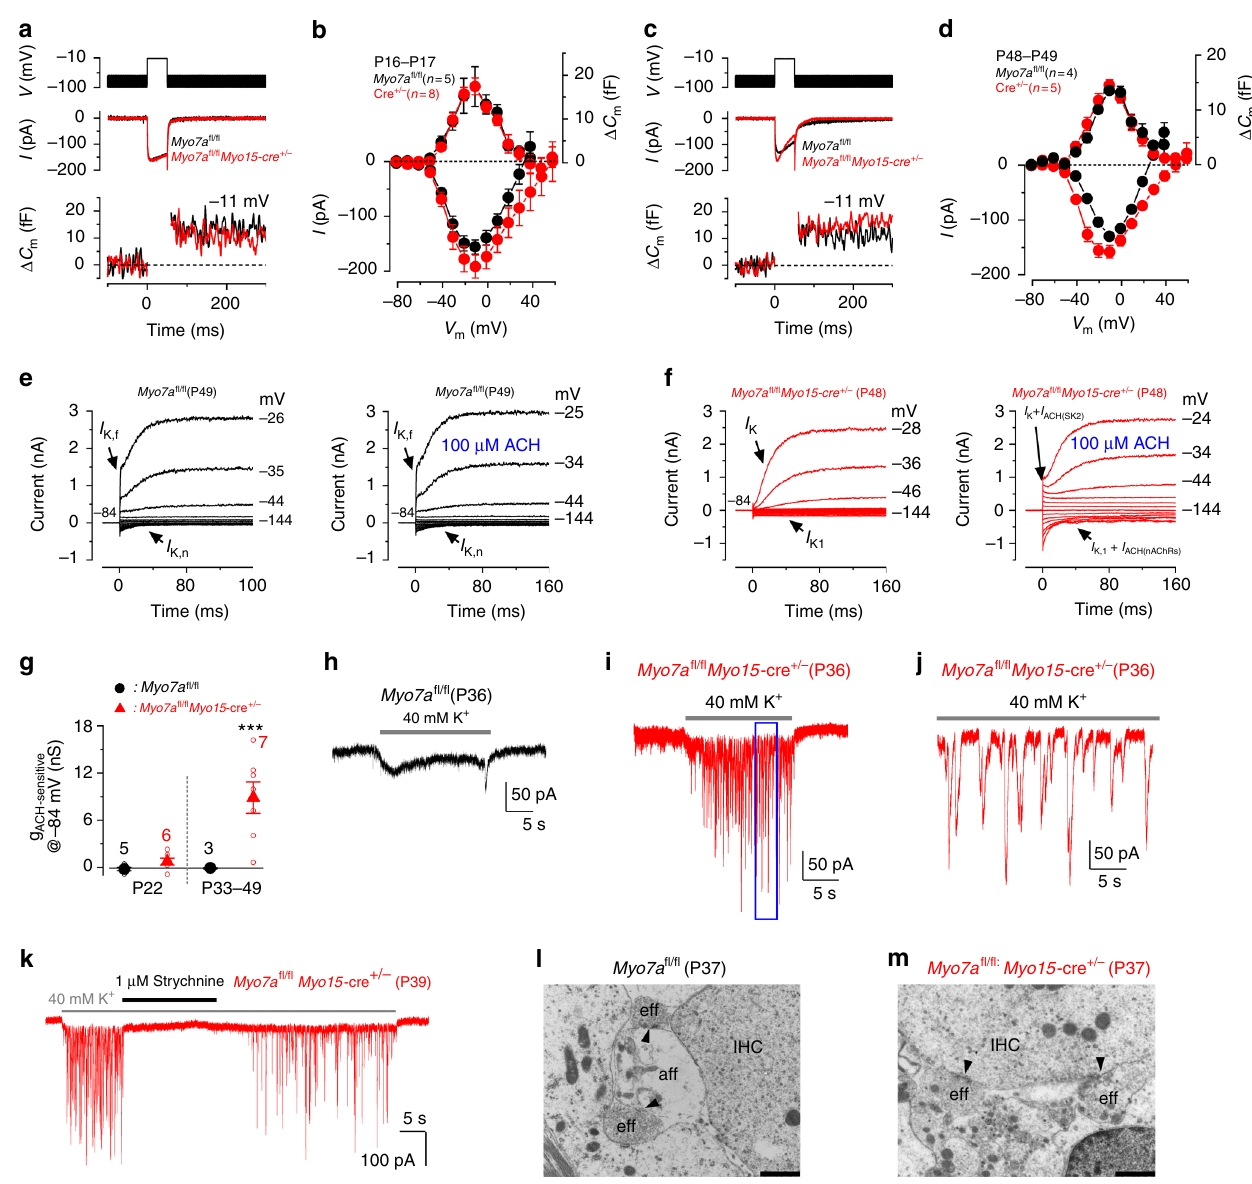
Fig. 7 IHC exocytosis is unaffected in adult Myo7a fl / fl Myo15 -cre + /- mice but efferent input is altered. a − d Calcium current ( I Ca ) and corresponding changes in membrane capacitance ( Δ C m ) recorded from IHCs of P16-P17 ( a , b ) and P48-P49 ( c , d ) control Myo7a fl / fl (black) and knockout Myo7a fl / fl Myo15 -cre + /- mice (red). Recordings were obtained in response to 50 ms voltage steps (10 mV increments) from − 81 mV and using 1.3 mM extracellular Ca 2 + and at body temperature. For clarity, only maximal responses at − 11 mV are shown. Panels b and d shows average peak I Ca (bottom) and Δ C m (top) curve from control Myo7a fl / fl and Myo7a fl / fl Myo15 -cre + /- IHCs. e , f Membrane currents recorded from adult IHCs of control Myo7a fl / fl ( e ) and Myo7a fl / fl Myo15 -cre + /- ( f ) mice before (left panels) and during superfusion of ACh (right panels). ACh elicited an instantaneous current only in the Myo7a fl / fl Myo15 -cre + /- IHC. g Steady-state slope conductance of the ACh-sensitive current (g ACh-sensitive ) at different age ranges in control Myo7a fl / fl (black symbols) and Myo7a fl / fl Myo15 -cre + /- (red symbols) IHCs. The isolated g ACh-sensitive was obtained by subtracting the control current (left panels in e , f ) from that in the presence of 100 μ M ACh (right panels) 35 . Number of IHCs is shown near the symbols (2 Myo7a fl / fl mice at P22 and P33-P49; 3 Myo7a fl / fl Myo15 -cre + /- mice at P22; 5 Myo7a fl / fl Myo15 -cre + /- mice at P34-P48). h – k Voltage-clamp recordings obtained from adult IHCs of control Myo7a fl / fl ( h , P36) and Myo7a fl / fl Myo15 -cre + /- ( i , j , P36; k P39) mice during the superfusion of 40 mM extracellular K + . Synaptic currents were only evoked in Myo7a fl / fl Myo15 -cre + /- IHCs. Panel j shows an expanded time scale of the blue area shown in panel ( i ). Panel k shows the effect of 1 μ M strychnine on the ACh-induced synaptic currents. l , m TEM showing the IHC synaptic region from P37 control Myo7a fl / fl ( l ) and Myo7a fl / fl Myo15 -cre + /- ( m ) mice. IHCs from Myo7a fl / fl mice showed the characteristic synaptic organization of mature cells with efferent terminals forming axo-dendritic contact with the afferent fi bers, as seen by the presence of active zones ( l , black arrows). Scale bars, 1 μ m. In Myo7a fl / fl Myo15 -cre + /- mice efferent fi bers make direct axo-somatic contact with the IHC ( m ), which is characteristic of pre-hearing IHCs. Average data is shown as mean ±